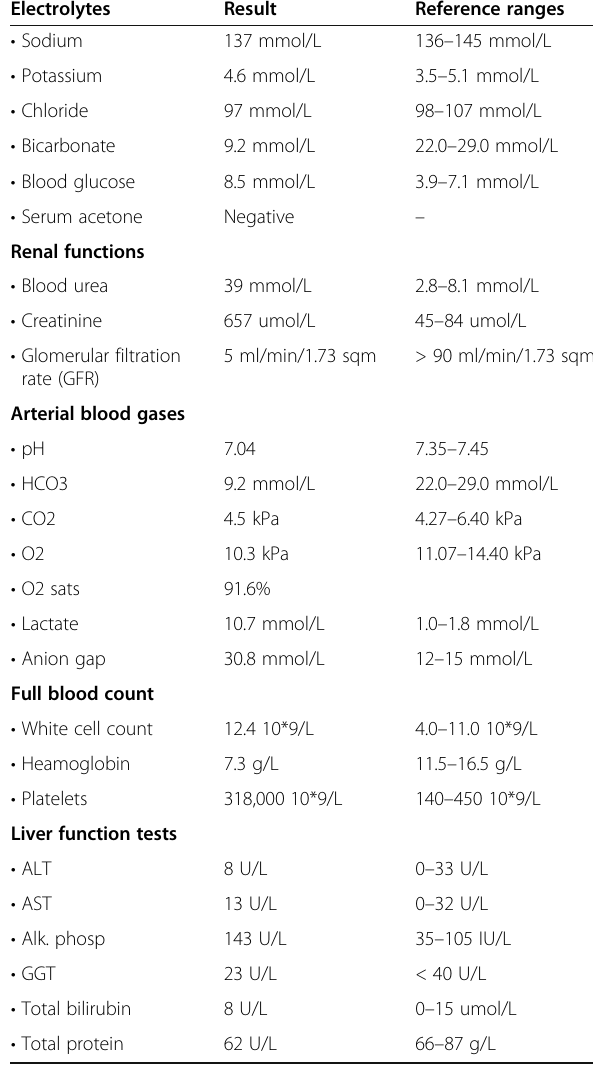
Table 1 Showing blood Investigations at the time of arrival Electrolytes